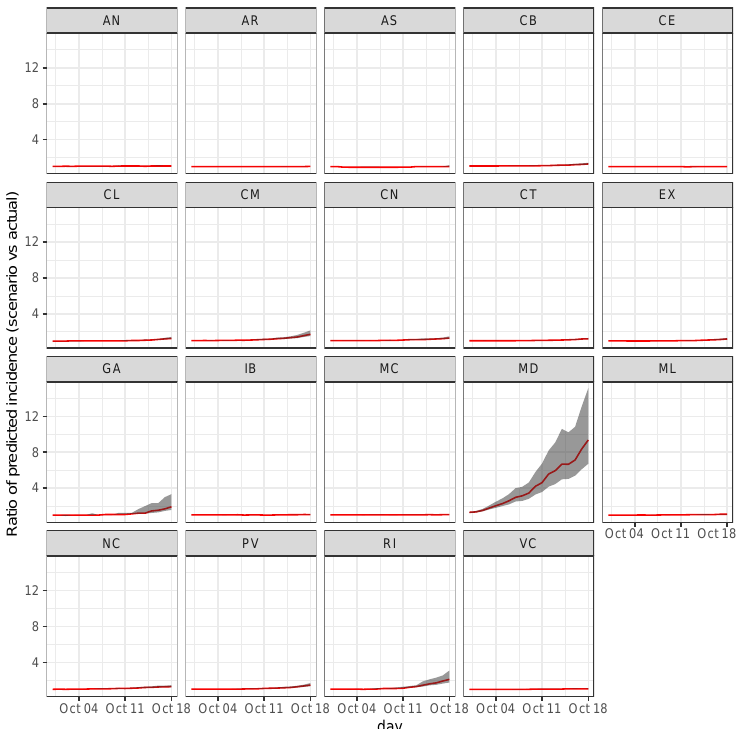
Figure A6. Effect on regions for a sudden increase of cases in Madrid. The ratio between the predicted incidence for the scenario against the actually predicted incidence. Red is the ratio among medians along with 99% credible intervals (shaded grey area).